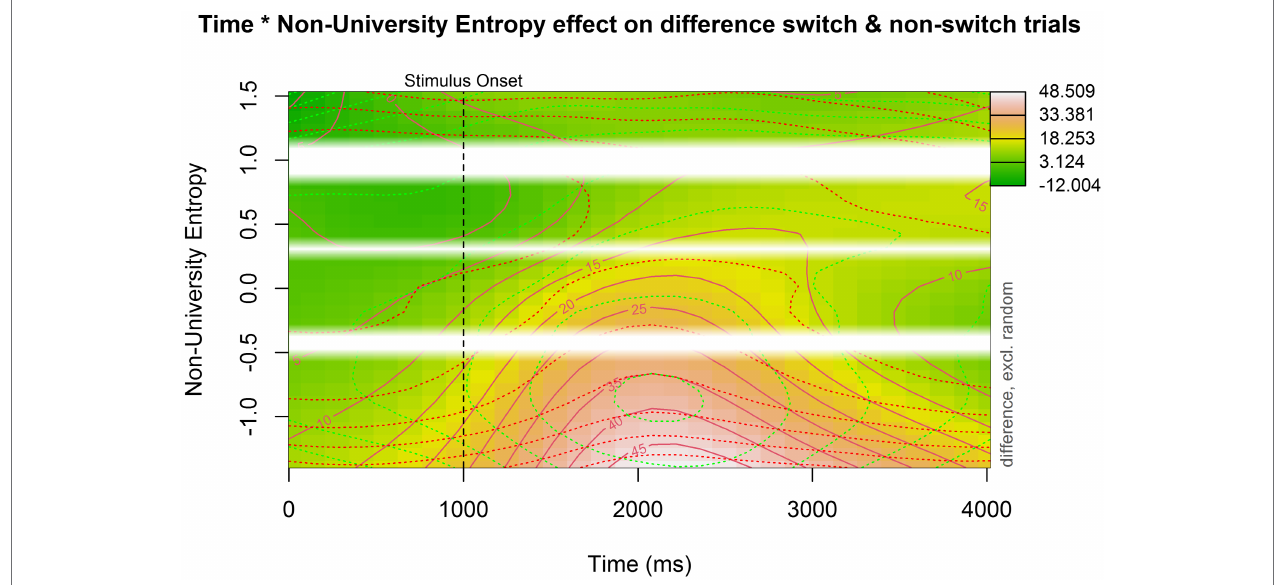
FIGURE 6 | Contour plot showing the interaction between non-university entropy, time, and the pupil switching cost. Time is plotted on the x -axis, non-university entropy is plotted on the y -axis, and the pupil switching cost is indicated by color: darker green indicates a smaller difference. The more red or even white the plot becomes, the larger the pupil switching cost. The white bars indicate missing data (i.e., non-existing entropy values in our